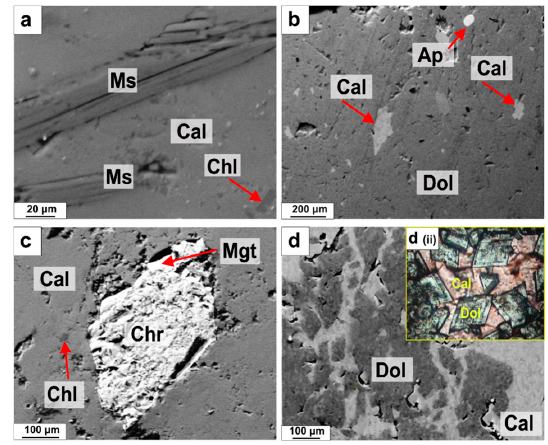
granular or massive. The matrix of these rocks in most cases ranges from microsparitic to sparitic.